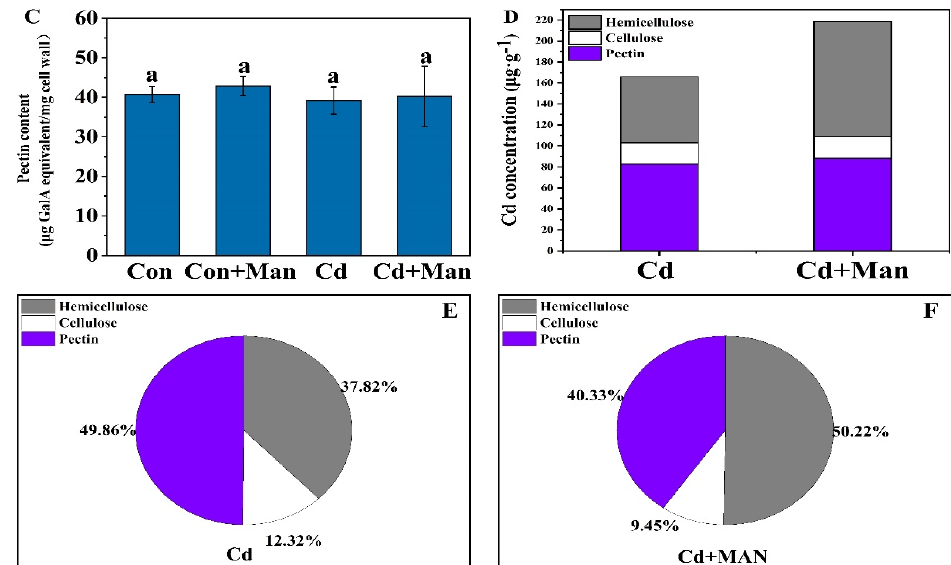
Figure 5. Effects of MAN on the cellulose content ( A ); the total sugar residues content in hemicellulose ( B ); the pectin content, calculated as Gal A in the cell wall of wheat roots under Cd stress ( C ); the Cd content in the cell wall component of wheat roots ( D – F ). One-week-old wheat seedlings under 20 µ M CdCl 2 were sprayed with 0 or 160 μ M MAN for two weeks. Data are the means ± SD and different letters above columns indicate a significant difference at p ≤ 0.05 among treatments.